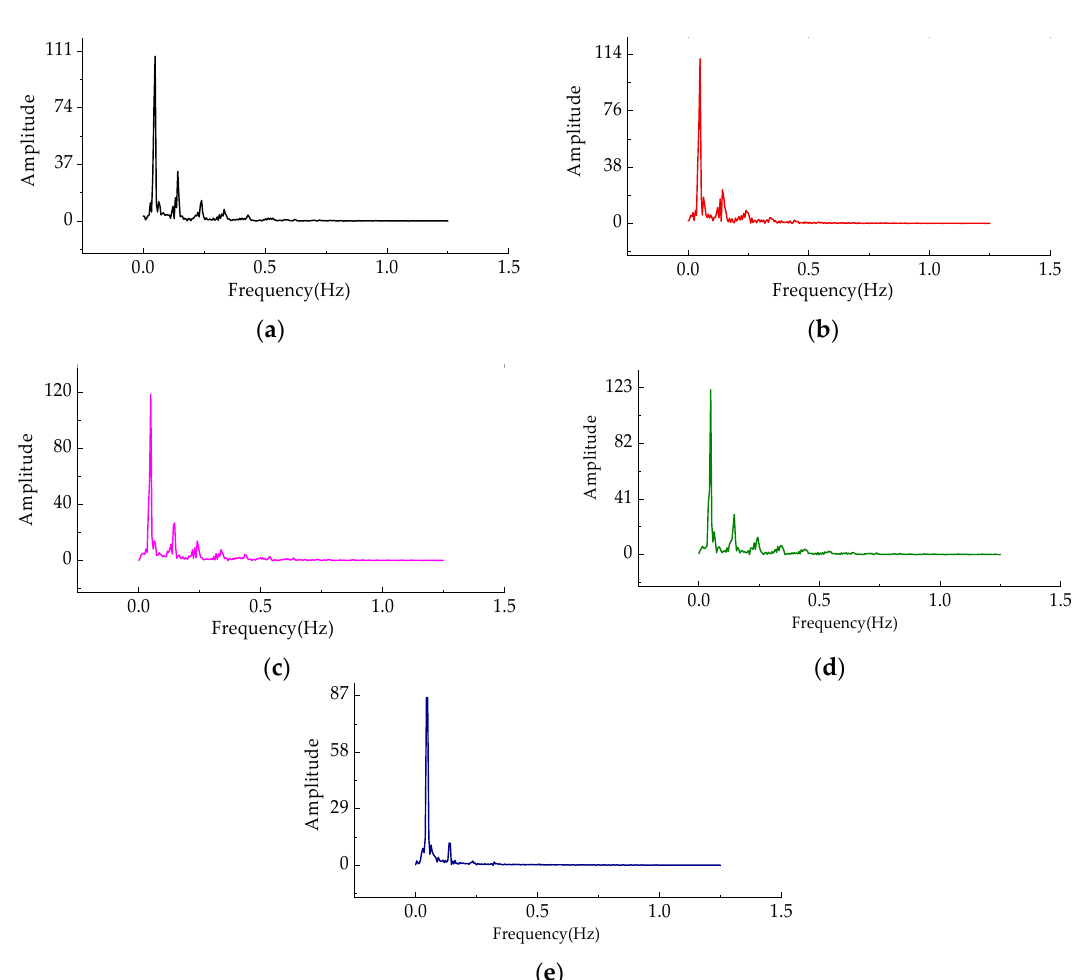
Figure 15. Measuring points.